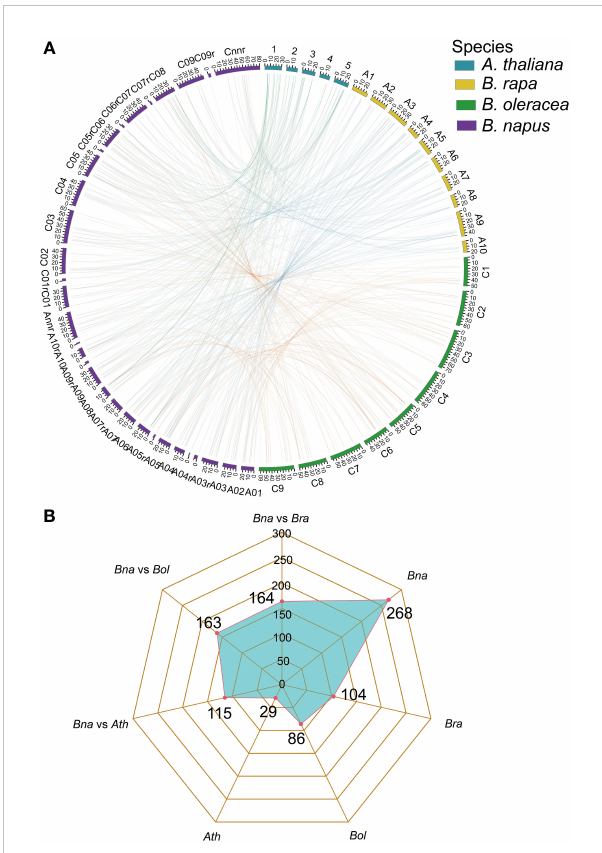
FIGURE 4 Genome-wide synteny analysis of UBC genes among A. thaliana , B. napus , B. rapa , and B. oleracea (A) Collinearity among the UBC genes in A. thaliana , B. rapa , B. oleracea , and B. napus . The chromosomes of A. thaliana , B. rapa , B. oleracea and B. napus were indicated with different colors corresponding to the color legend at the top right. Green lines represented the collinearity between A. thaliana and B. napus . The blue lines represented the collinearity between B. rapa and B. napus . The orange lines represented the collinearity between B. oleracea and B. napus . The visualization of the collinear correlations was performed by CIRCOS software. (B) Radar charts showed the number of orthologous and paralogous gene pairs of UBC s across four plant